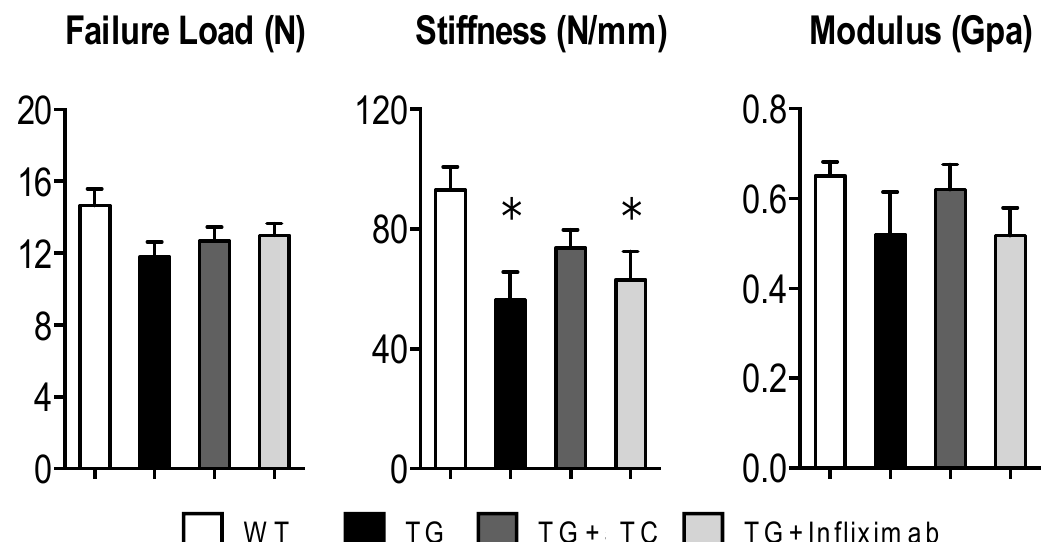
Figure 5. TC exhibited a modest improvement of bone stiffness devastated by TNF overexpression. Right femurs were placed on the machine with a three-point bending mechanical system to measure and determine failure load, stiffness, and modulus. The 5% and 10% TC mice were combined for these parameters to make a total of four groups: WT, TG, TG + TC, and TG + infliximab. Values are means ( n = 4–9) ± SEM. *, p < 0.05 vs WT.